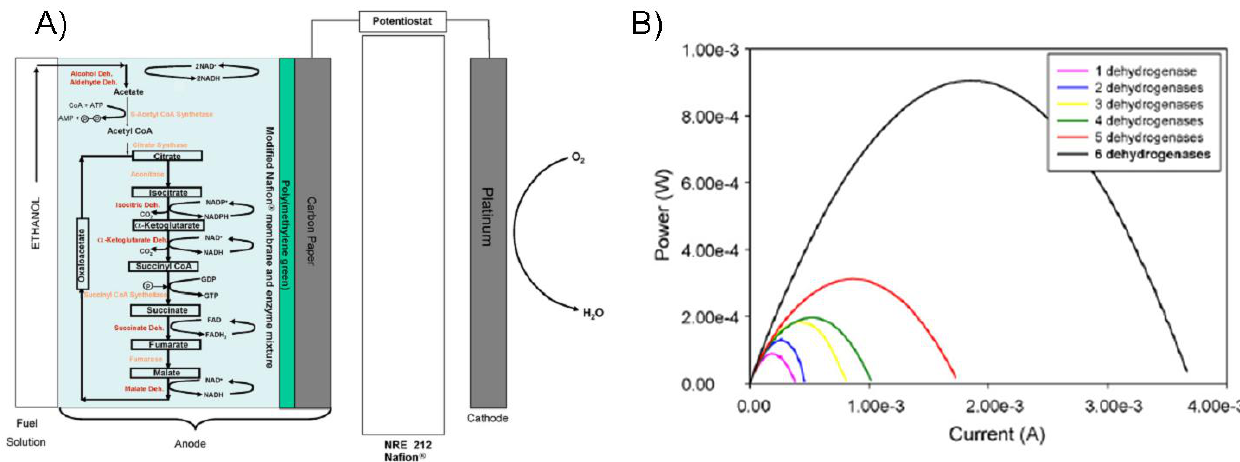
Figure 12. (A) Schematic presentation of a biofuel cell based on ethanol as a fuel for bioelectrochemical mimicking of the citric acid cycle. (B) Representative power curves of biofuel cells employing different number of enzymes. Reprinted from [44] with permission from